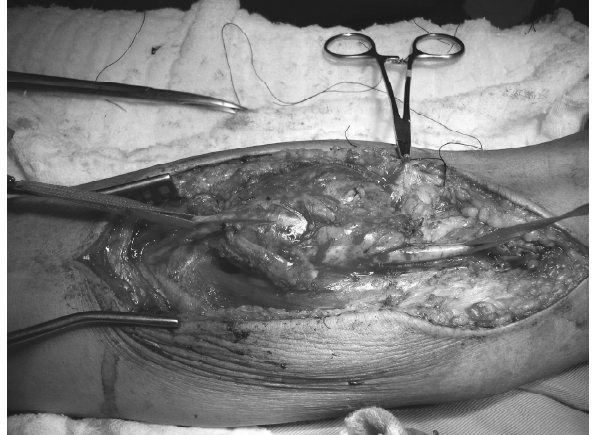
Fig. 2 - Imagem cirúrgica do aneurisma da artéria braquial direita, comprometendo sua bifurcação. Encontra-se reparada com fita cardíaca, à direita, a artéria braquial proximal ao comprometimento aneurismático